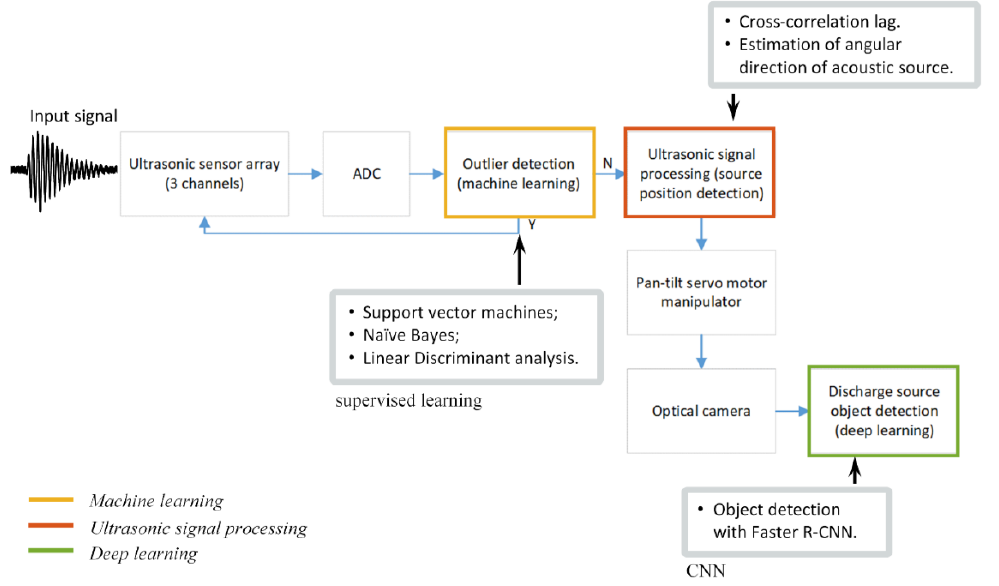
Figure 1. The architecture of proposed discharge detection system.